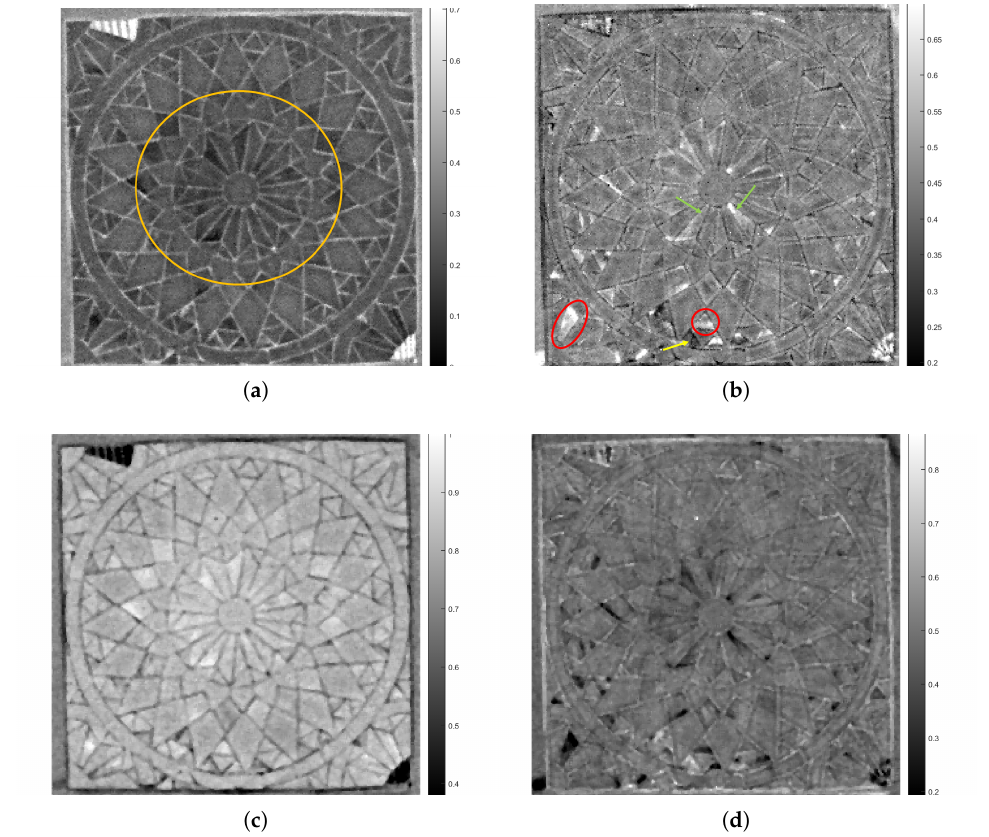
Figure 7. PCT results obtained from infrared sequences. ( a ) Second EOF from MWIR, ( b ) third EOF from MWIR, ( c ) second EOF from LWIR, and ( d ) third EOF from